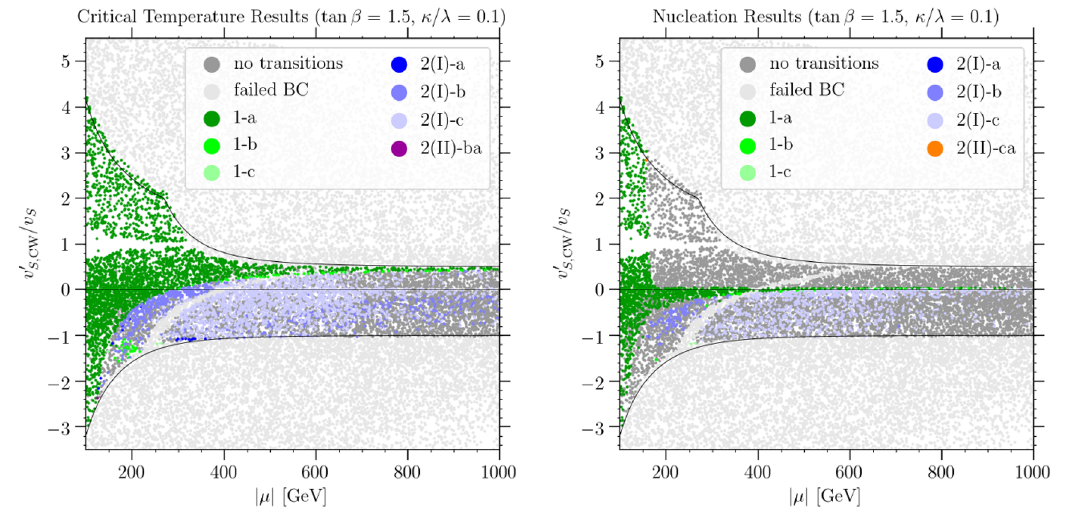
Figure 6 . Same as figure 4, but for tan β = 1 . 5 and κ/λ = 0 . 1 .